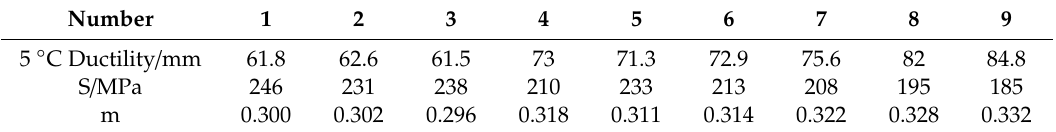
Table 5. Orthogonal test results of low temperature performance index of